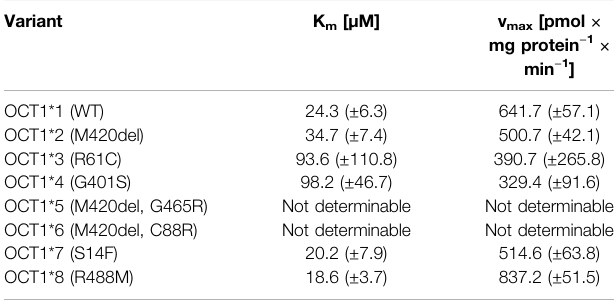
TABLE 2 | Kinetic parameters for the transport of mescaline by different OCT1 genetic variants.